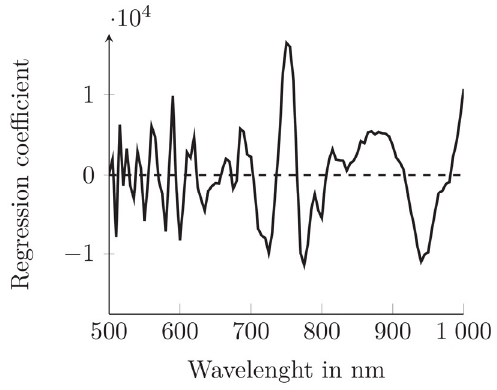
Figure 5. Regression coefficients of the best PLSR calibration model.